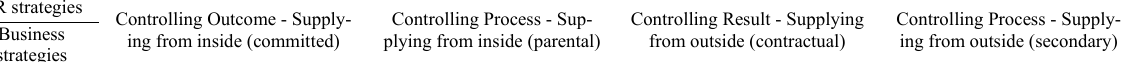
Sample of Delphi Questionnaire for aligning strategies HR